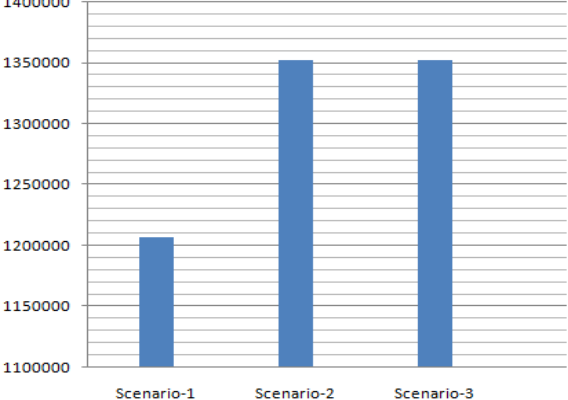
Figure 10. Comparison of total fuzzy profit.